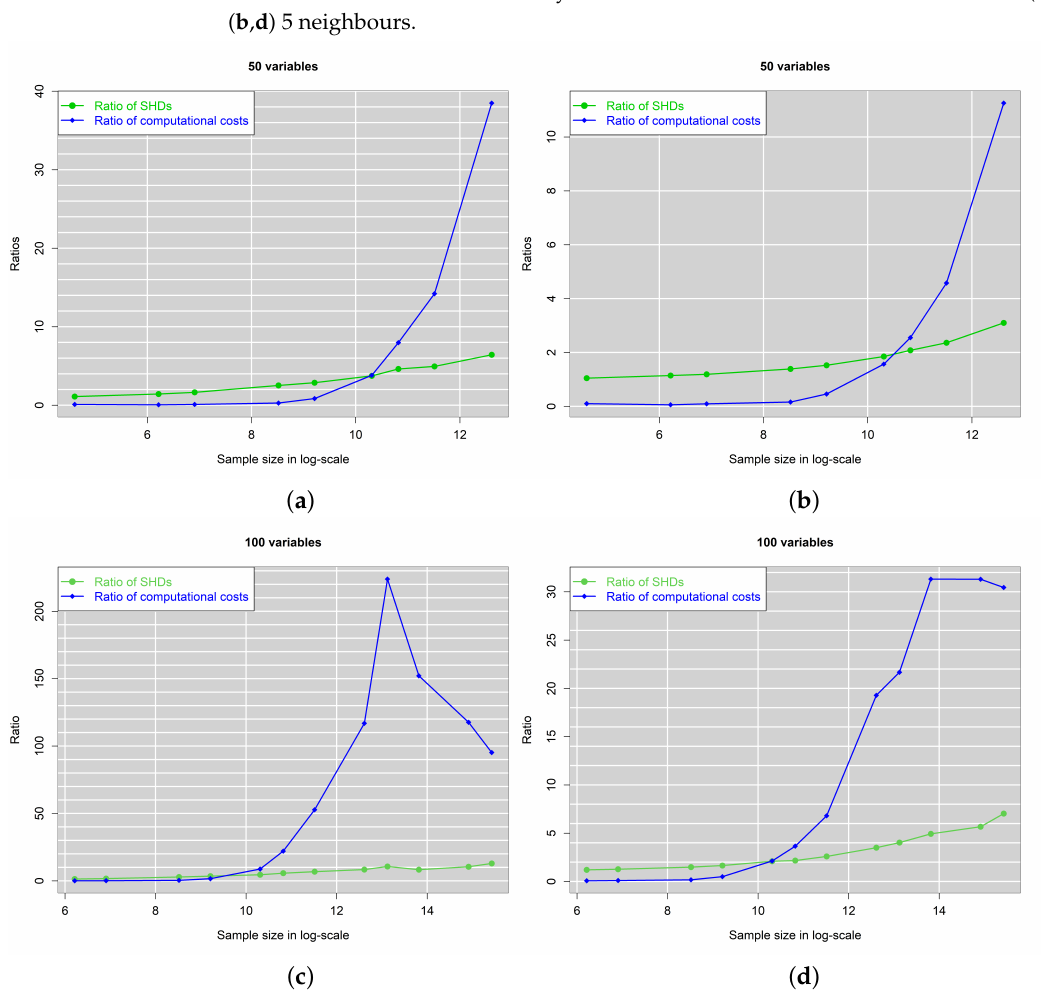
Figure 9. Ratios of SHD and computational cost against log of sample size for 50 and 100 dimensions with 3 neighbours and 5 neighbours on average. The ratios depict the errors and computational cost of the raw FEDHC relatively to the robustified FEDHC with 5% outliers. ( a , c ) 3 neighbours. ( b , d ) 5